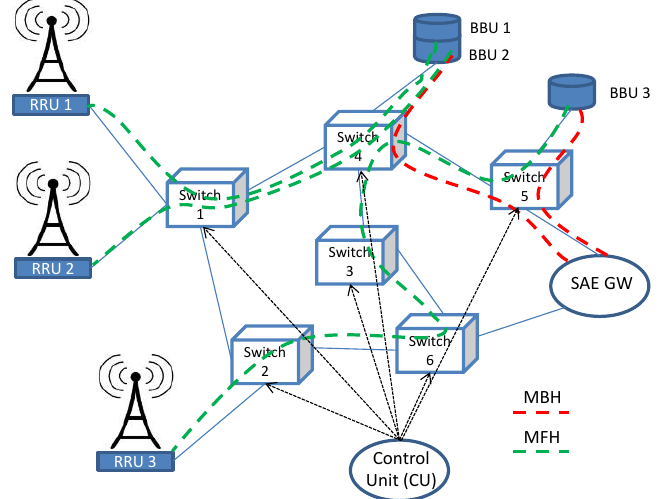
Figure 14. Possible architecture for converged metro-access MBH/MFH network.